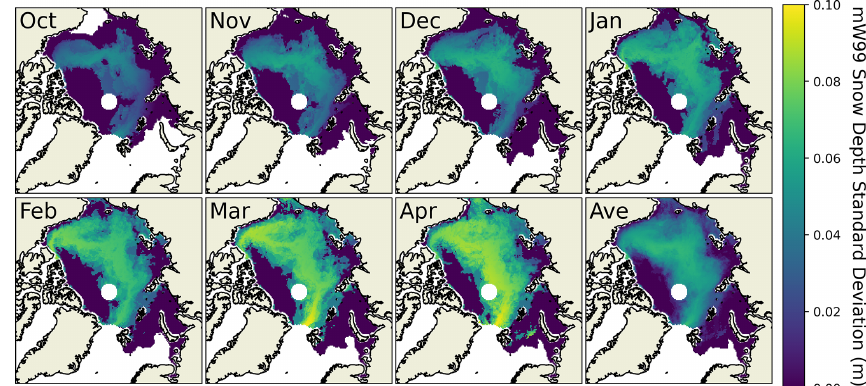
Figure 4. mW99 snow-depth variability at each EASE grid point over the 2002–2018 period. This is calculated by generating a time series of snow depth at each point and then calculating the standard deviation of that time series. High variability is displayed in a band where sea ice type typically fluctuates from year to year. IAV is zero in areas that do not exhibit sea ice type variability, introducing unphysically low variability in